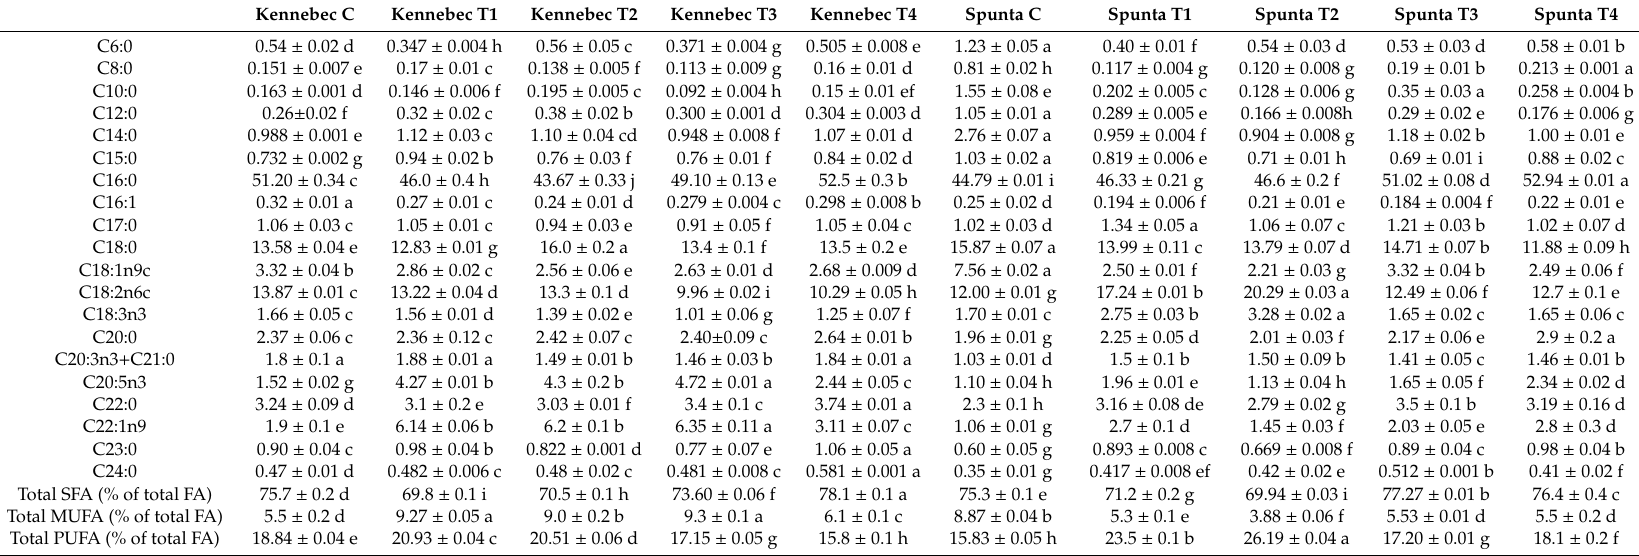
Table 8. Fatty acids composition (%) of the studied potato varieties in relation to the fertilization regime (mean ±